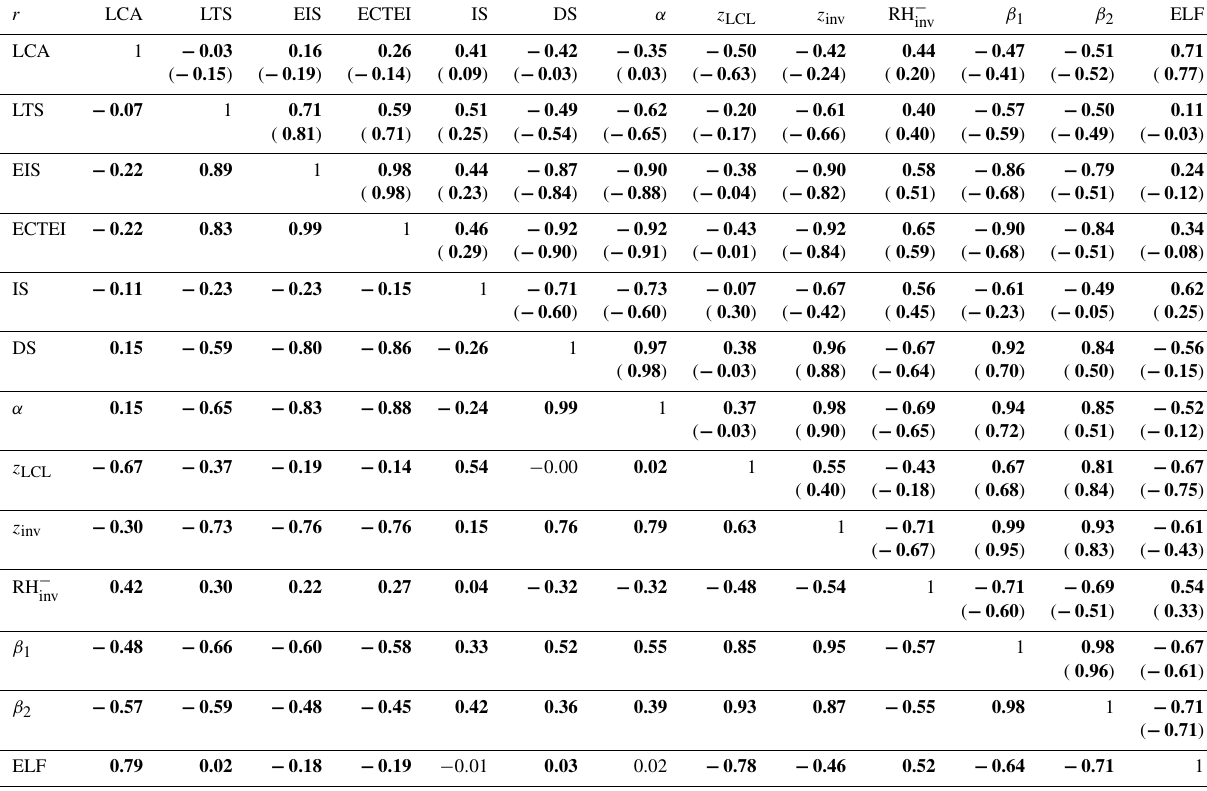
Table 6. The same as Table 3, but all data (i.e., 0 < α < 1 and α = 0 and α = 1) are used for this